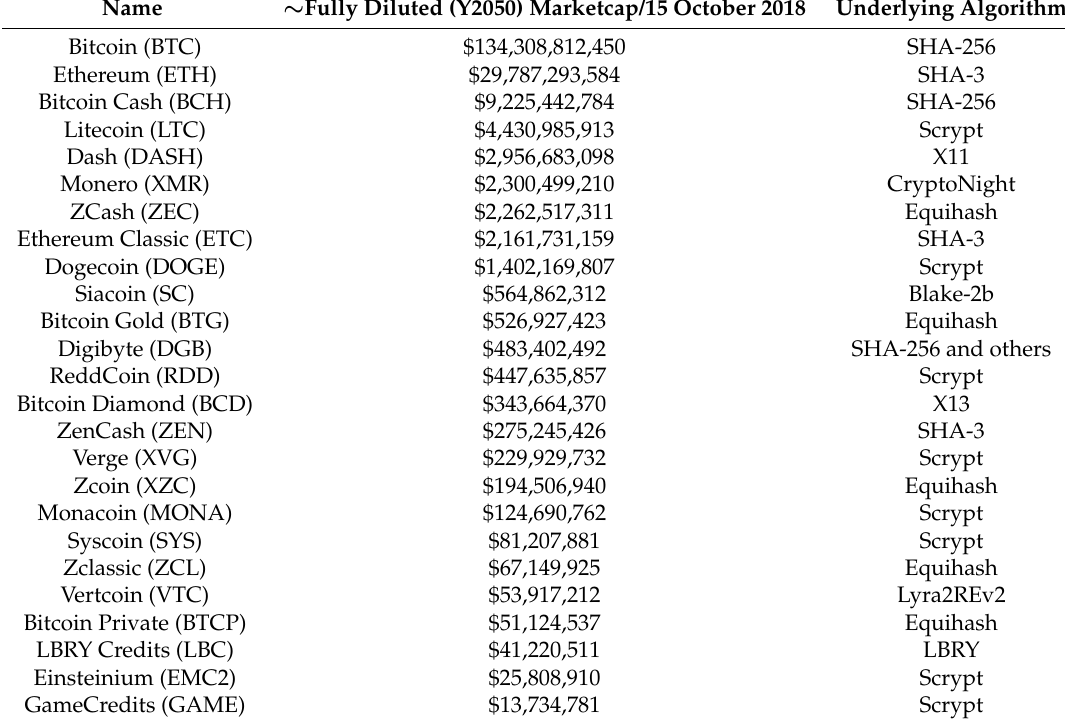
Table 1. The 25 top cryptocurrencies as of 15 October 2018 as can be seen on https://onchainfx.com/